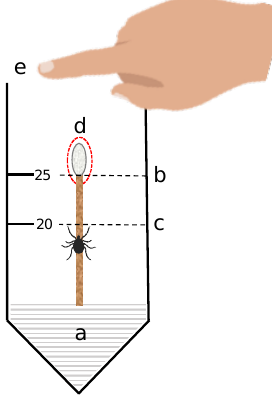
Figure 1. Vertical bioassay setup: A cotton swap is inserted in a Falcon tube and secured at the base with a polystyrene platform ( a ). The base of the cotton swap tip is aligned with the 25 mL line ( b ); the tick is released at the bottom of the cotton tip just below the 20 mL line. The timer starts when the tick crosses the 20 mL line ( c ); the treatment is applied on top of the swab ( d ); the observer exposes a finger on the open top of the Falcon tube to stimulate the tick to climb the slender surface ( e ).